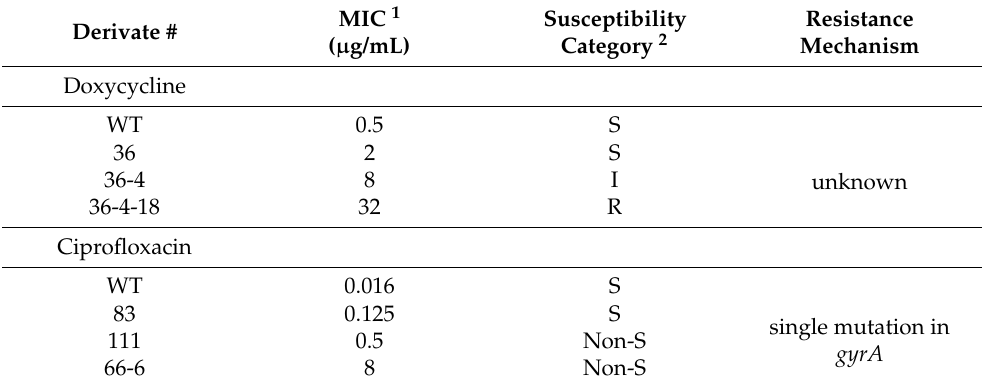
Table 1. Y. pestis Kimberley53 ∆ 70 ∆ 10 derivates with reduced susceptibility to